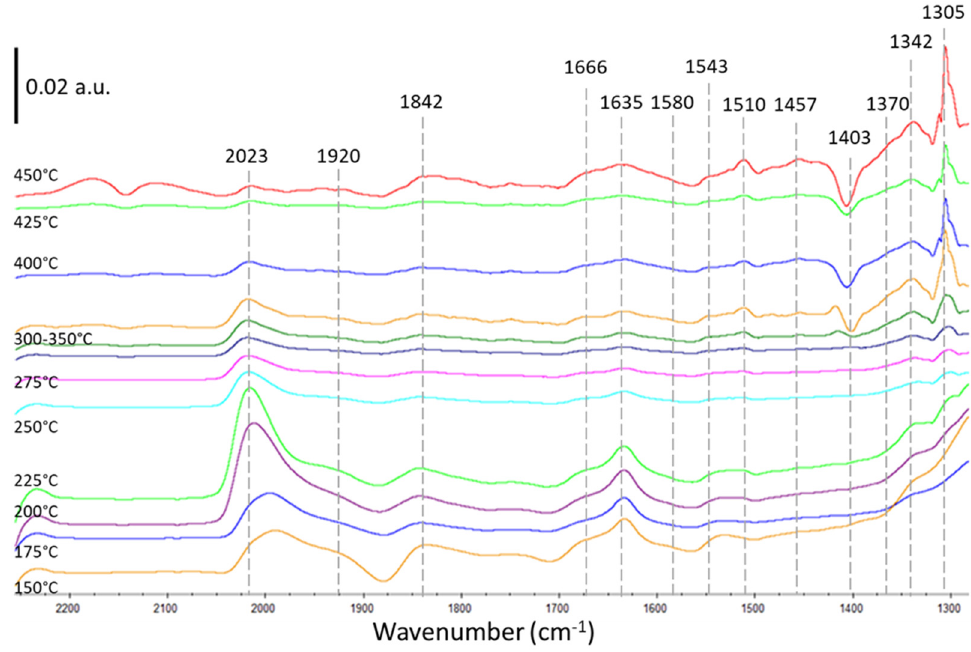
Figure 4. FTIR spectra obtained under CO 2 methanation conditions for 3Ru/CsUSY in the 2300–1300 cm − 1 region at different temperatures.